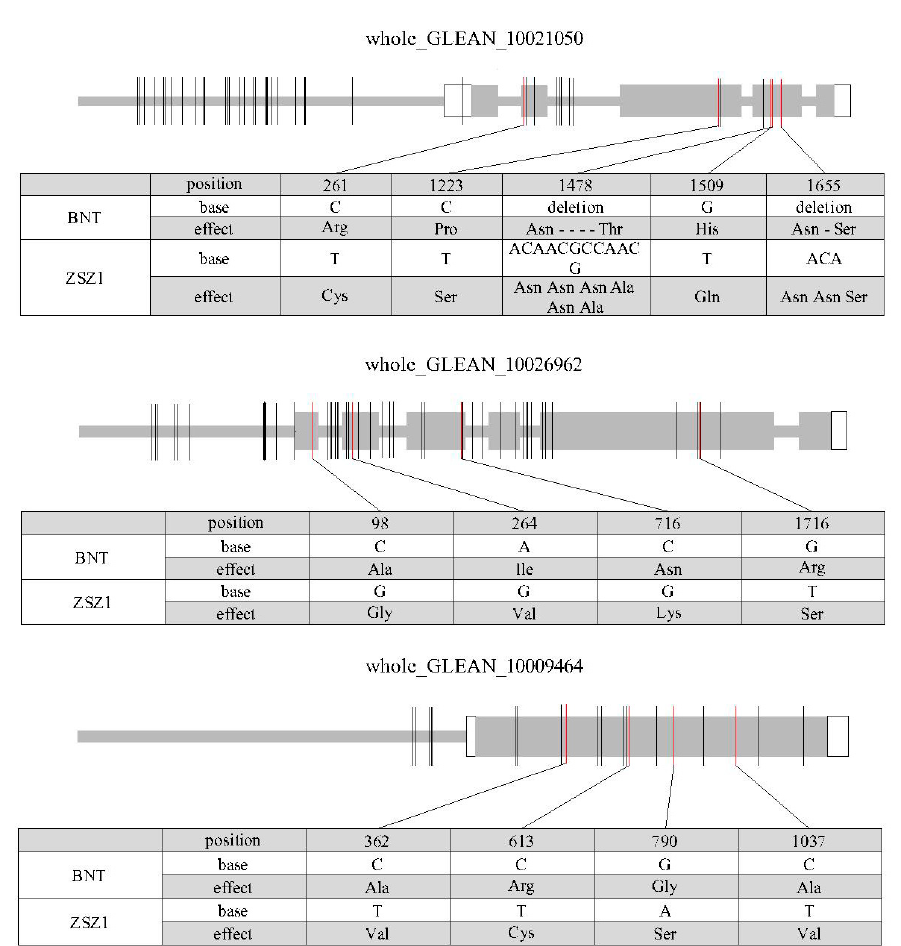
Figure 3. Sequence variation of the three candidate genes in the two parents, BNT and ZSZ1. The gray and white rectangles indicate the coding sequence (CDS) and untranslated region (UTR), respectively. The thick gray lines before the UTR and in the inter-exon region represent the putative promoter and intron region, respectively. The vertical molding in the gene indicates variation in the corresponding position of a gene, and the red one in the CDS represents variation that caused the change in an amino acid. The tables under each figure show the detailed sequence variations in CDS and the corresponding amino acid change for each gene.